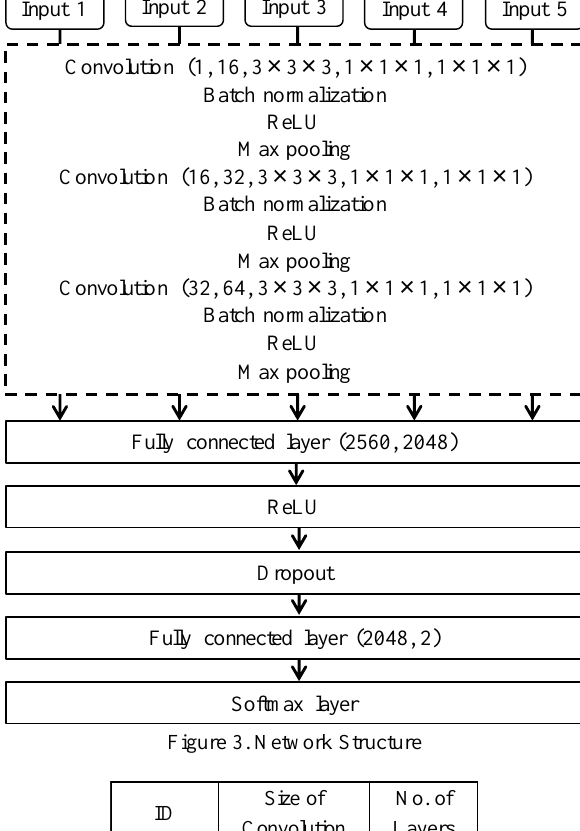
Figure 3. Network Structure